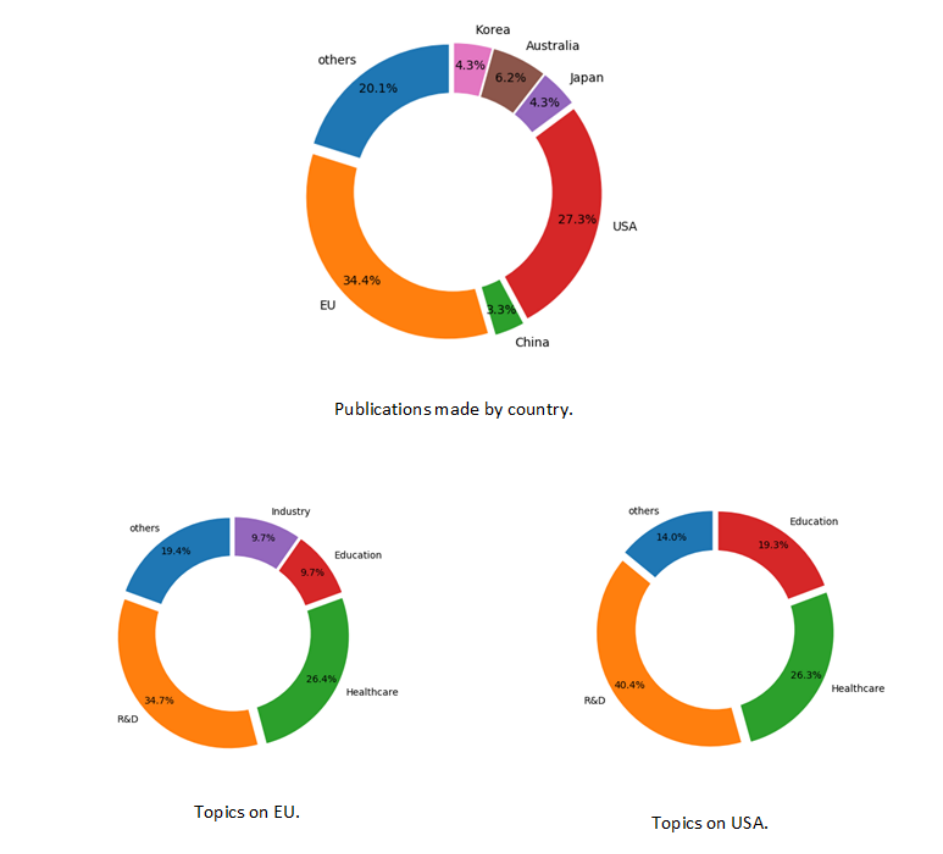
Figure 6. On the top is the percentage of countries which made a research on AR or VR; in the bottom left is the topics researched in the EU; and in the bottom right is the percentage of topics researched in the USA.